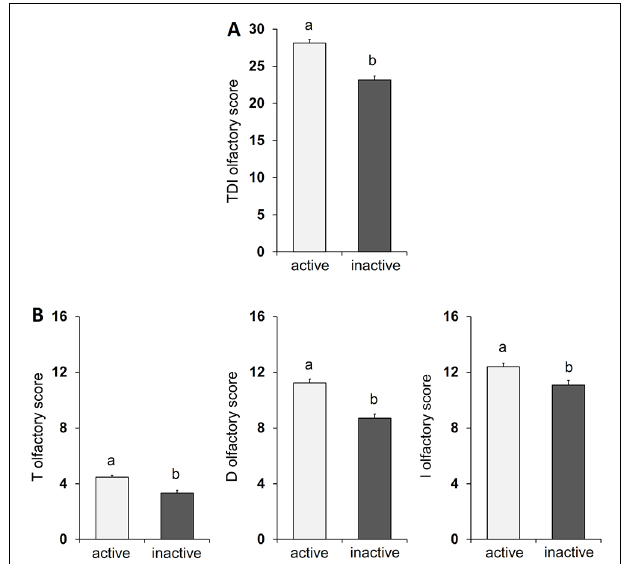
FIGURE 1 | Mean value ± SEM of the TDI olfactory score (A) and of the olfactory threshold (T), odor discrimination (D), and odor identification (I) scores (B) obtained by active HS ( n = 60) and inactive HS ( n = 62). Different letters indicate significant differences between lifestyles ( p < 0.05; Fisher’s LSD test subsequent to one-way ANOVA).